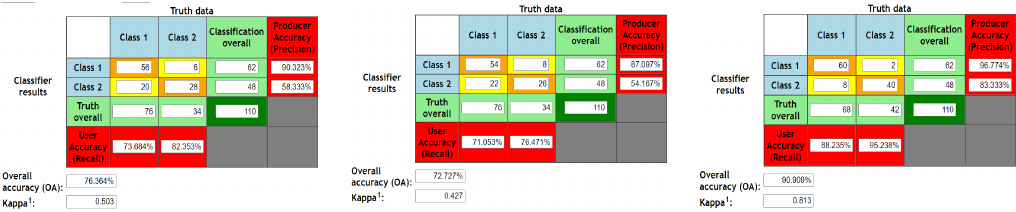
Figure 13. Confusion matrix for 5 fold cross validation of 3D Doppler images for SVM, LSTM and VAE-CNN respectively.